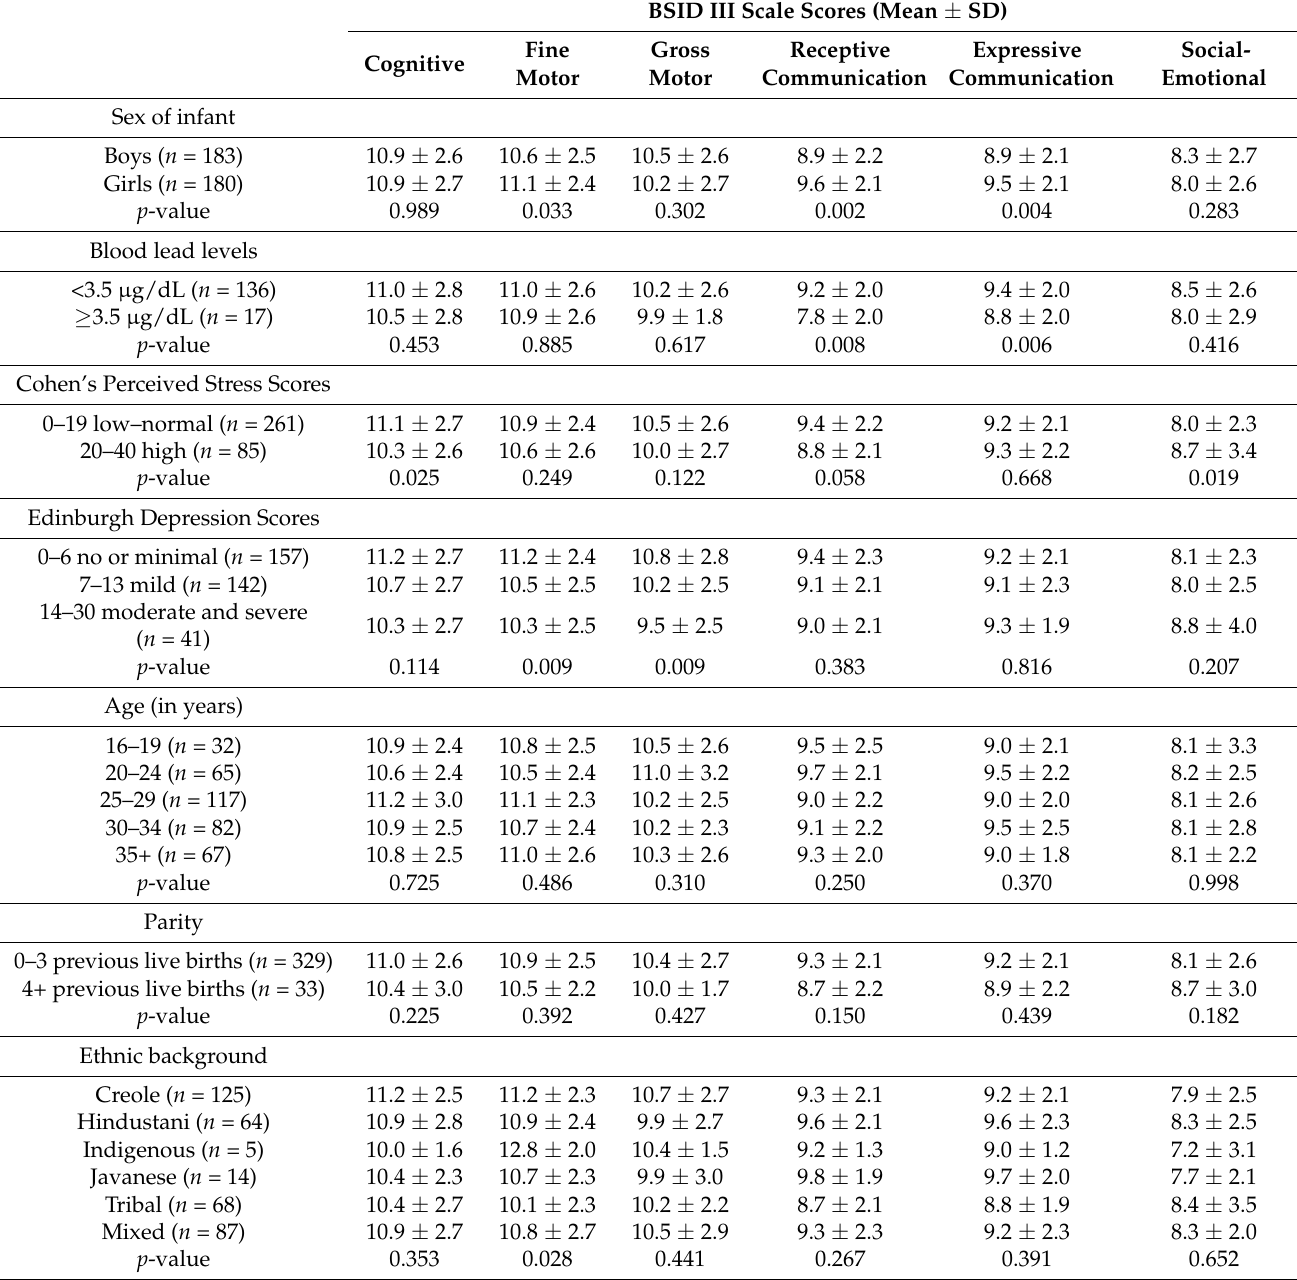
Table 2. Distribution of unadjusted BSID III scaled scores for maternal demographics as well as chemical and nonchemical stressors ( n = 363). BSID III Scale Scores (Mean ± SD) Fine Gross Receptive Expressive Social- Cognitive Motor Motor Communication Communication